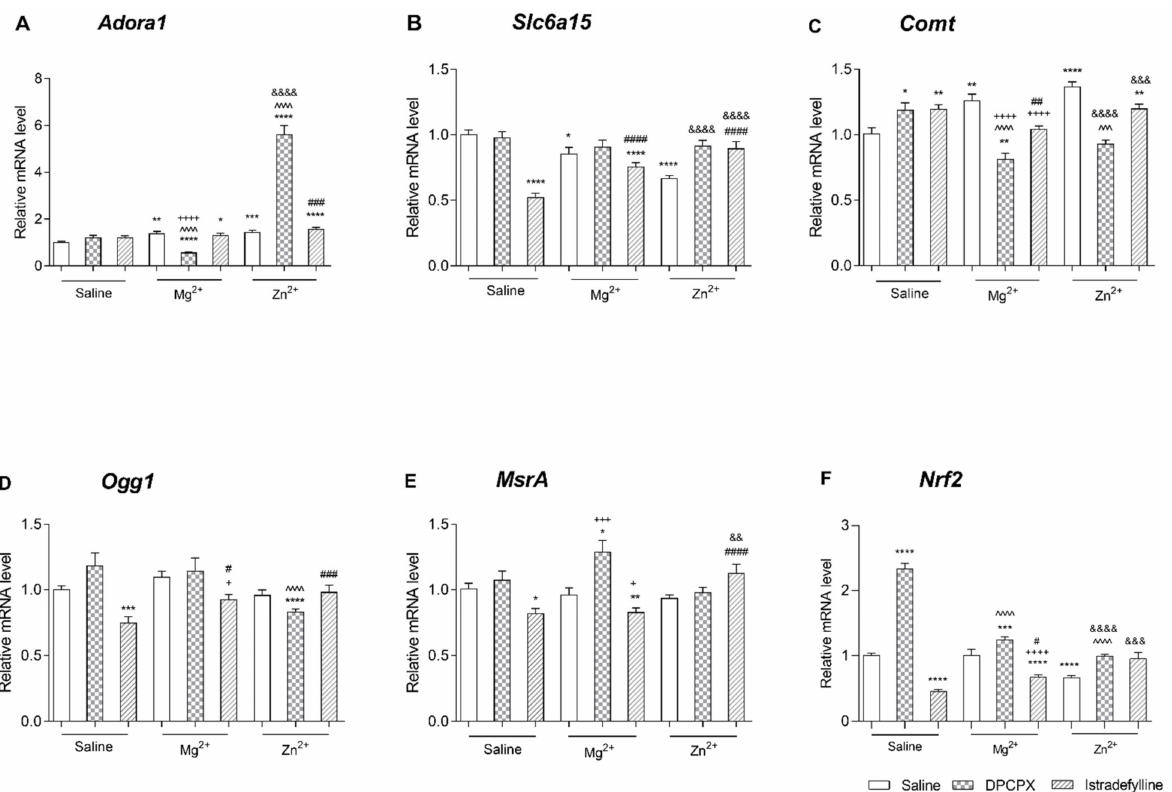
Figure 3. Effect of co-administration of DPCPX and istradefylline with Mg 2+ and Zn 2+ on gene expression ( A ) Adora1 , ( B ) Slc6a15 , ( C ) Comt , ( D ) Ogg1 , ( E ) MsrA , and ( F ) Nrf2 in mice prefrontal cortex. DPCPX, Mg 2+ and saline were